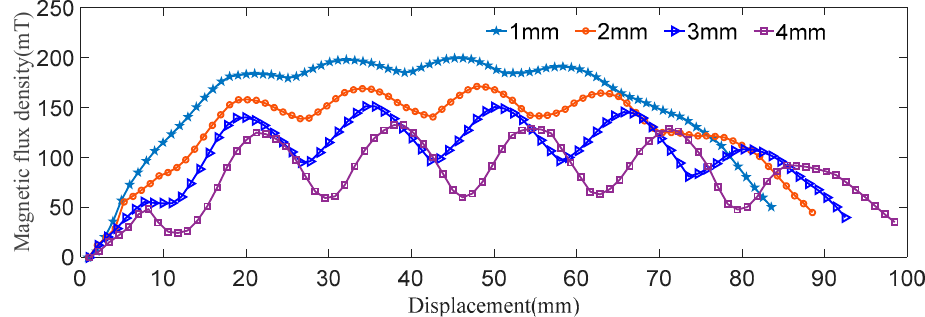
Figure 8. Effect of the heat dissipation ring’s thickness on the magnetic flux density.